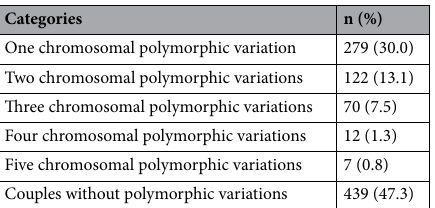
Table 5. Chromosomal polymorphic variations by number of variations per couple.